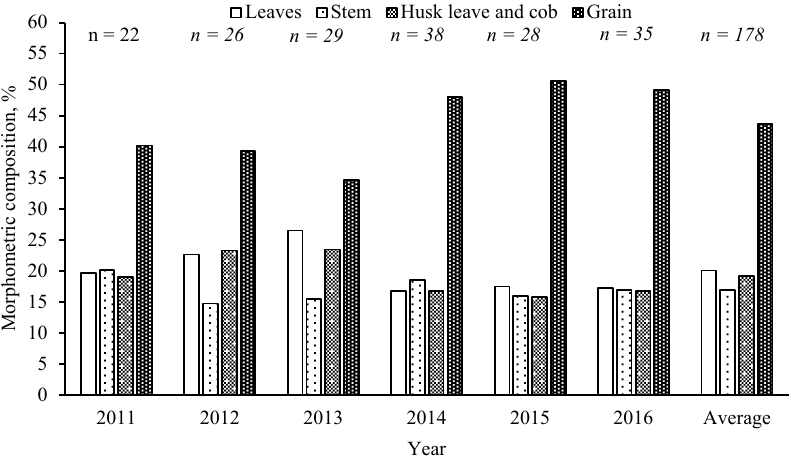
Figure 3. Plotting the equation fit and residues for estimating the DM content of the corn plant through the DM of the grains at the time of harvest. Data from 318 samples, collected from 63 farms in 16 municipalities in the state of Paraná, Brazil between 2011 and 2020.